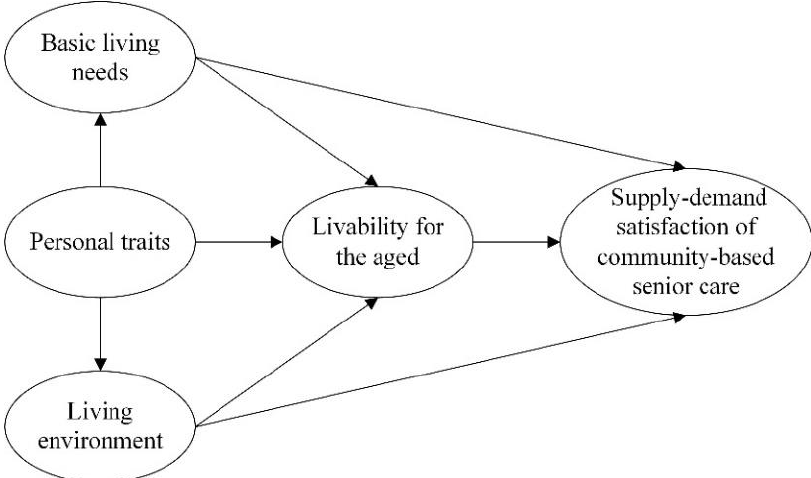
Figure 2. The model of the SSCSC.